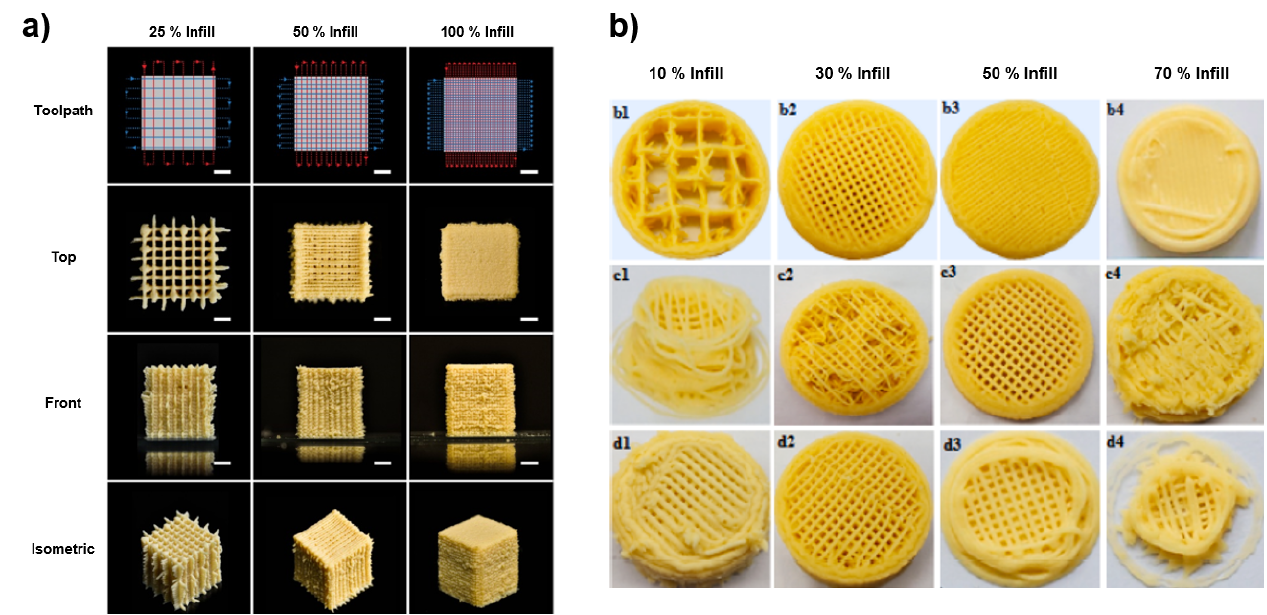
Figure 6. 3D-printed ( a ) okara cubes at different infill levels “Reprinted/adapted with permission from Ref. [62]. Copyright © 2021, American Chemical Society” and ( b ) wheat-flour cookies incorpo- rating okara fiber at different infill levels (b1 = 10%, b2 = 30%, b3 = 50%, b4 = 70%), nozzle diameters (c1 = 0.4 mm, c2 = 0.6 mm, c3 = 0.8 mm, c4 = 1 mm) and printing speeds (d1 = 25 mm/s, d2 = 50 mm/s, d3 = 75 mm/s, d4 = 100 mm/s) “Reprinted/adapted with permission from Ref. [63]. Copyright © 2021, Elsevier”